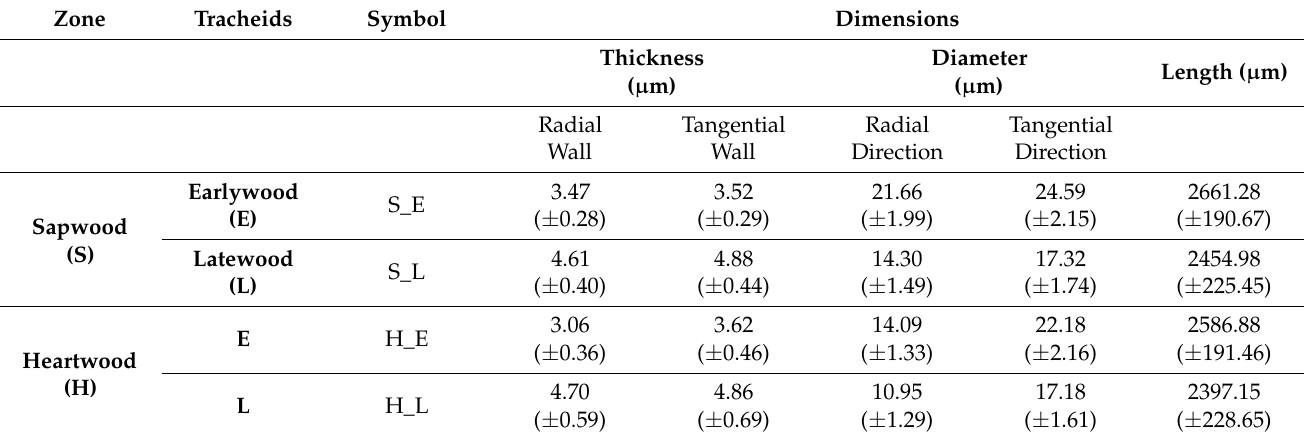
Table 1. Dimensions of the oriental arborvitae tracheids; ±